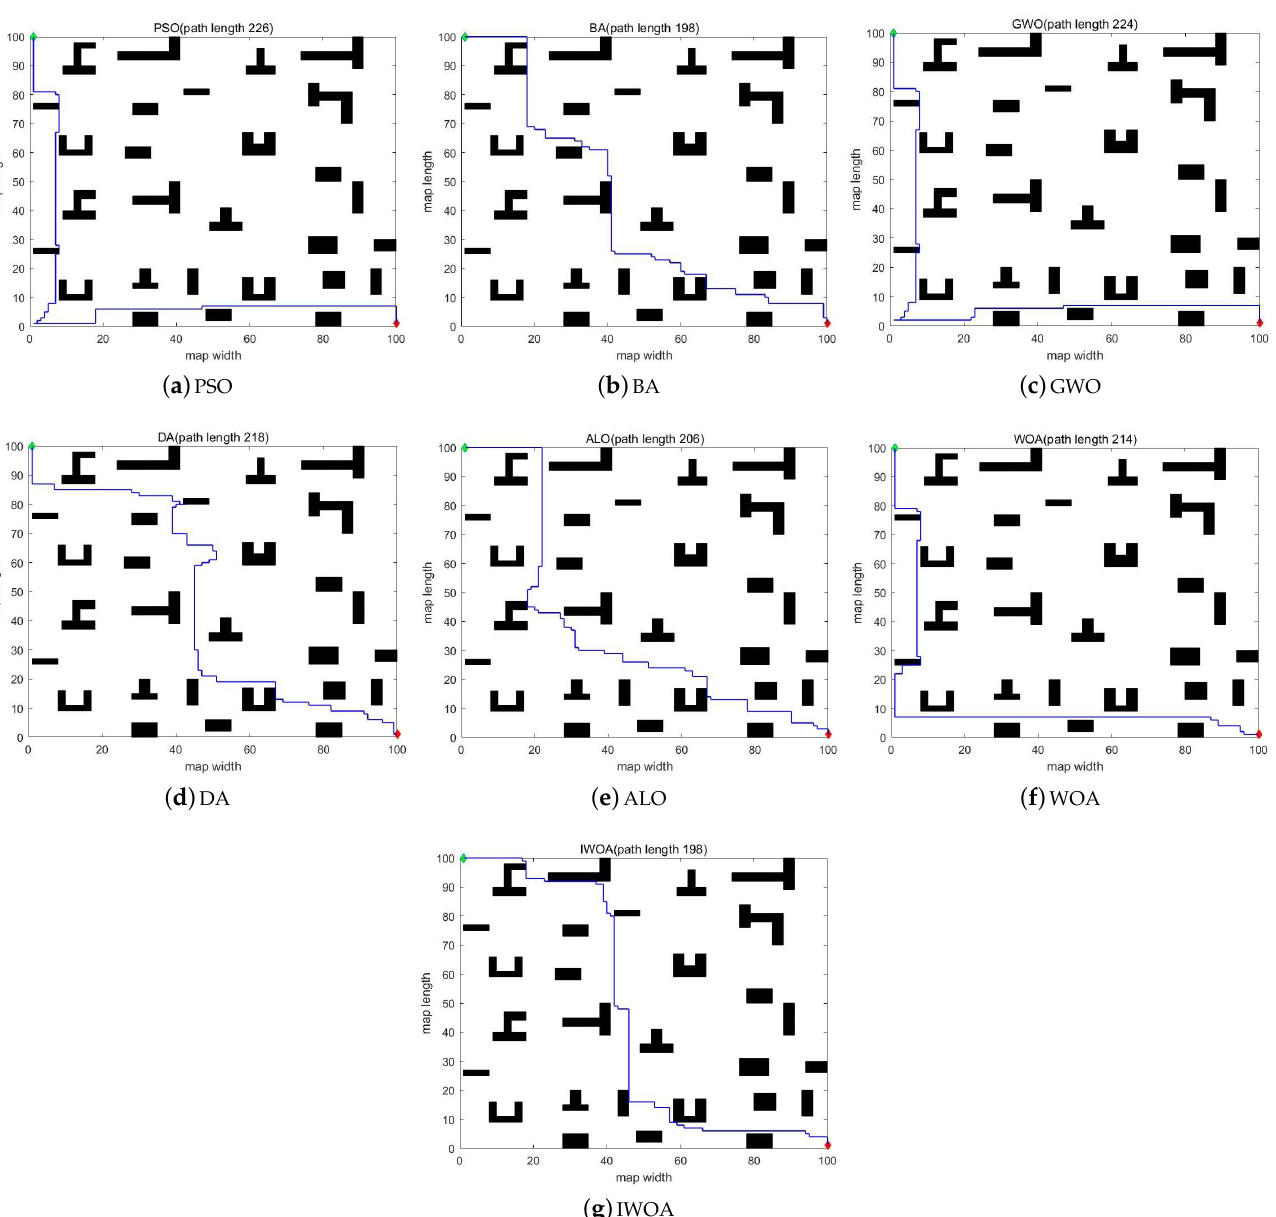
Figure 20. Actual path traces of seven different algorithms on 100 × 100 size